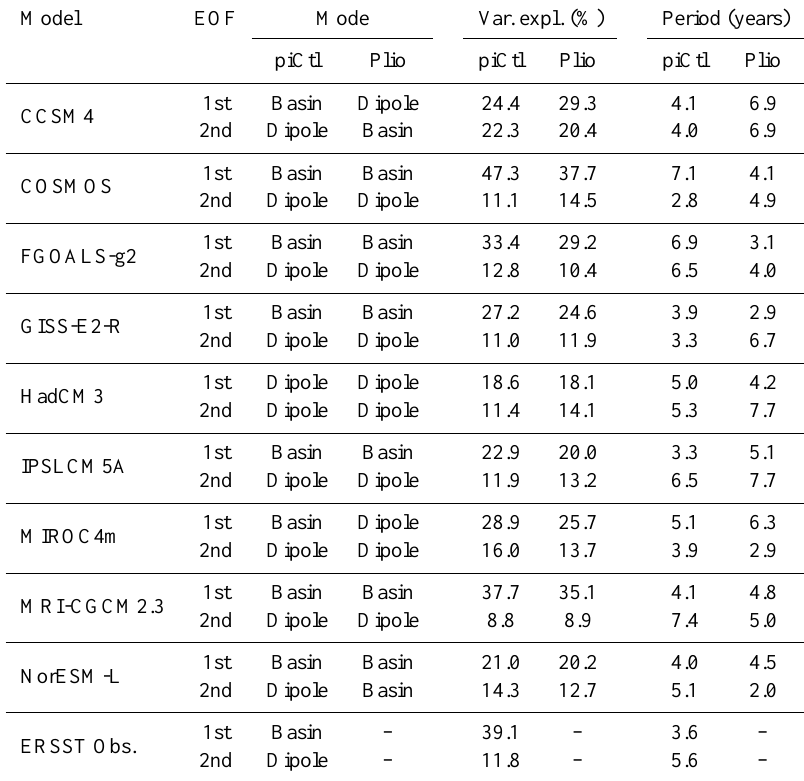
Table 3. Properties of empirical orthogonal functions (EOFs) of the Indian Ocean. The percentage of variance explained (var. expl.) by each model’s first two EOFs and the period with the most spectral power are shown. The correspondence of each EOF to physically meaningful modes of variability has been determined by visual inspection. The preindustrial and Pliocene simulations are denoted by piCtl and Plio,